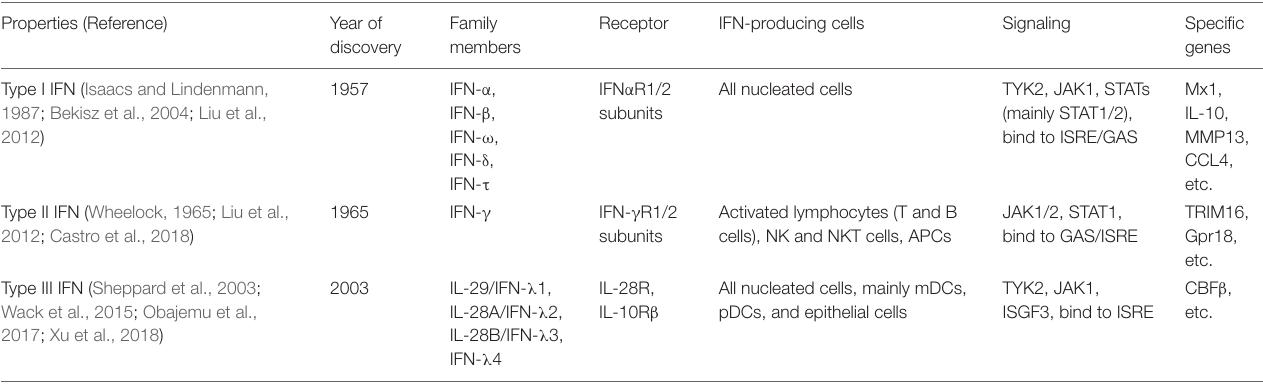
TABLE 1 | Current classification of human